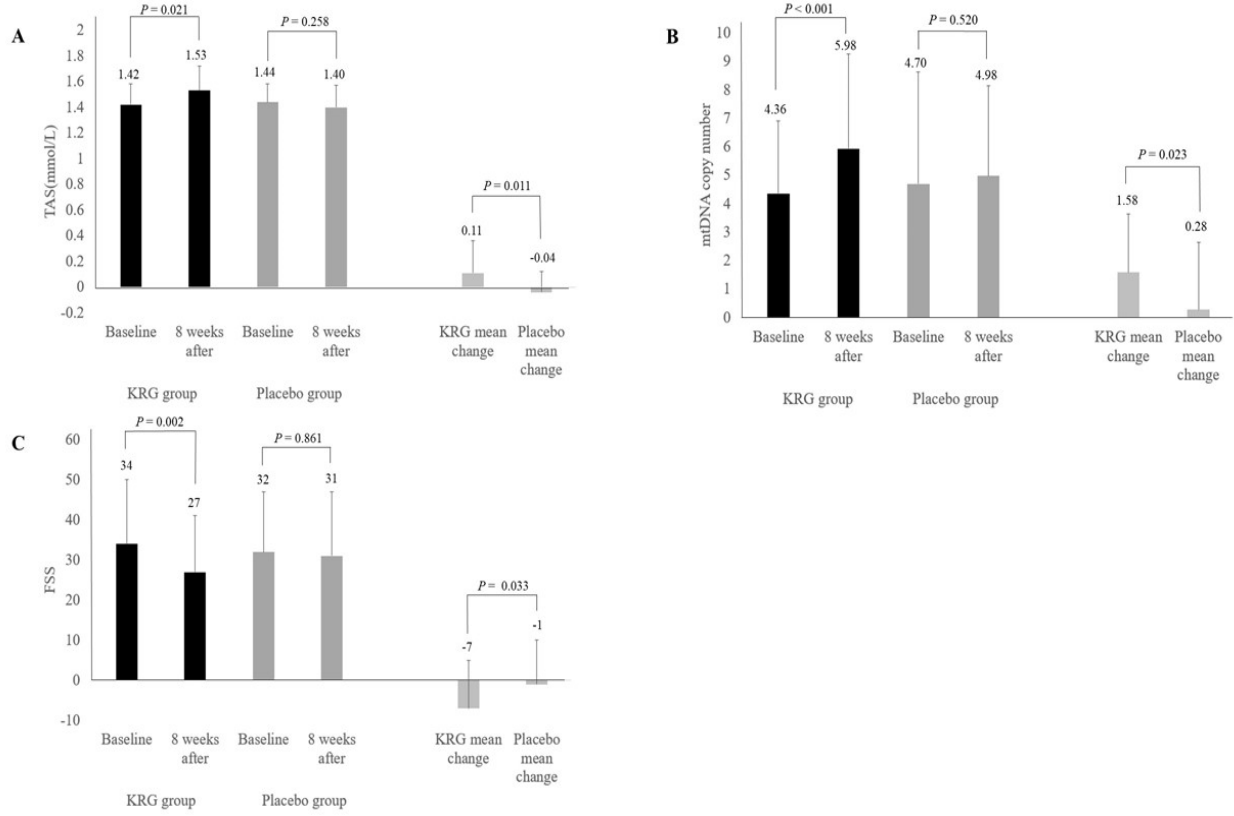
Figure 2. Changes in major results of the KRG and placebo groups before and after 8 weeks (bars mean standard deviation): ( A ) Total antioxidant status; ( B ) mtDNA copy number; ( C ) Fatigue severity scale. KRG, Korean red ginseng.